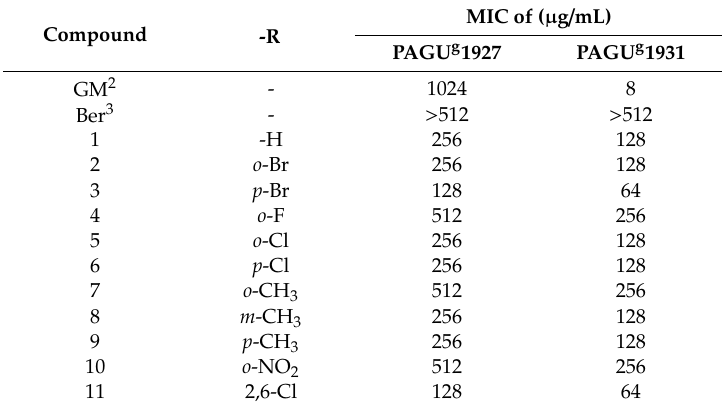
Table 1. Antibacterial activities of berberine derivatives against PAGU g 1931 and PAGU g 1927.